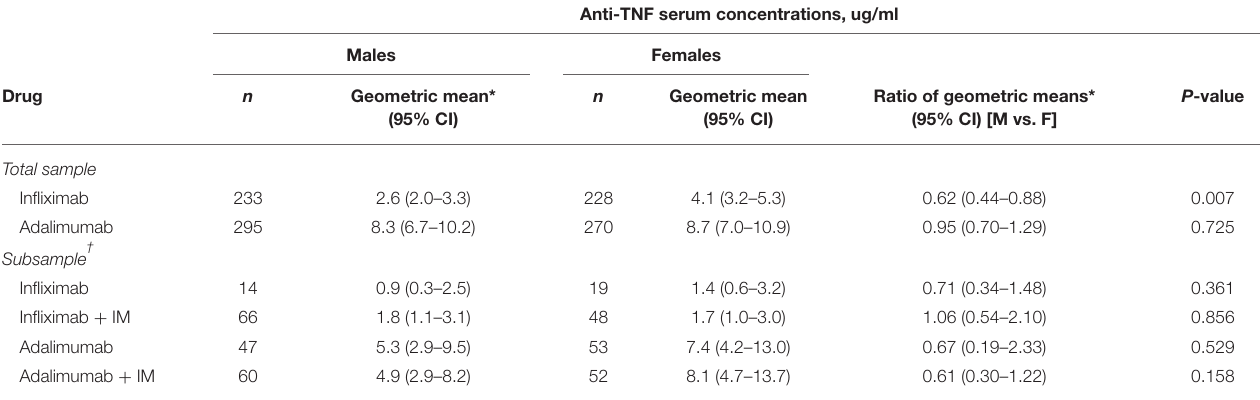
TABLE 3 | Anti-TNF serum concentrations stratified by sex according to monotherapy and combination therapy for infliximab and adalimumab use: inter-sex comparisons. Drug n Geometric mean*